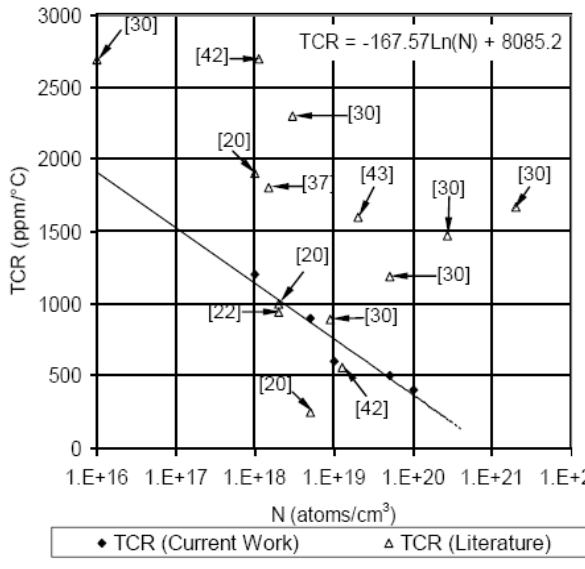
Figure 18. Temperature coefficient o f resistance (TCR) at different doping concentrations to evaluate the sensor